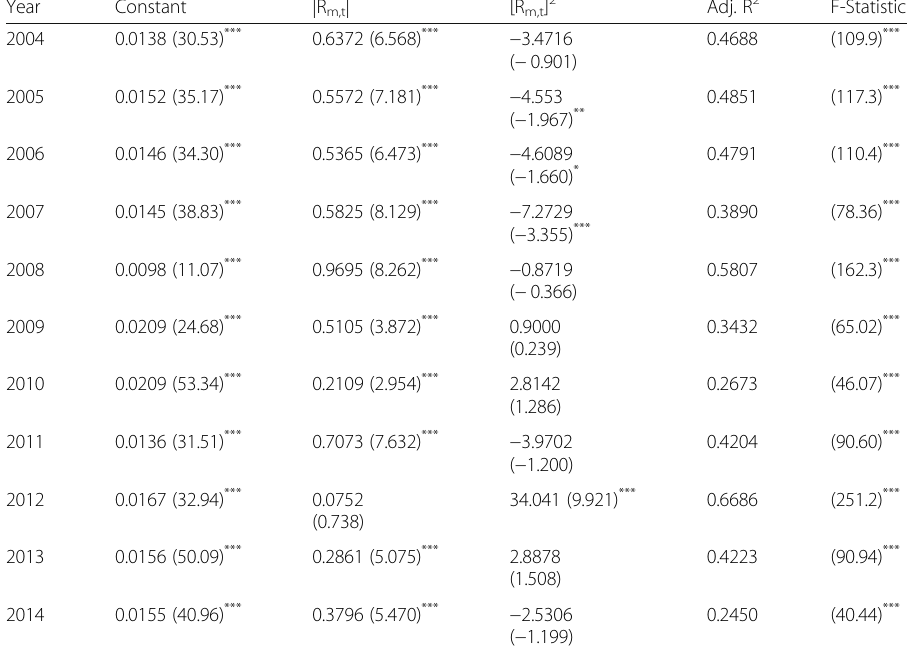
Table 6 Yearly Regression results for CSAD t Year Constant |R m,t | [R m,t ] 2 Adj. R 2 F-Statistic 2004 0.0138 (30.53) ***